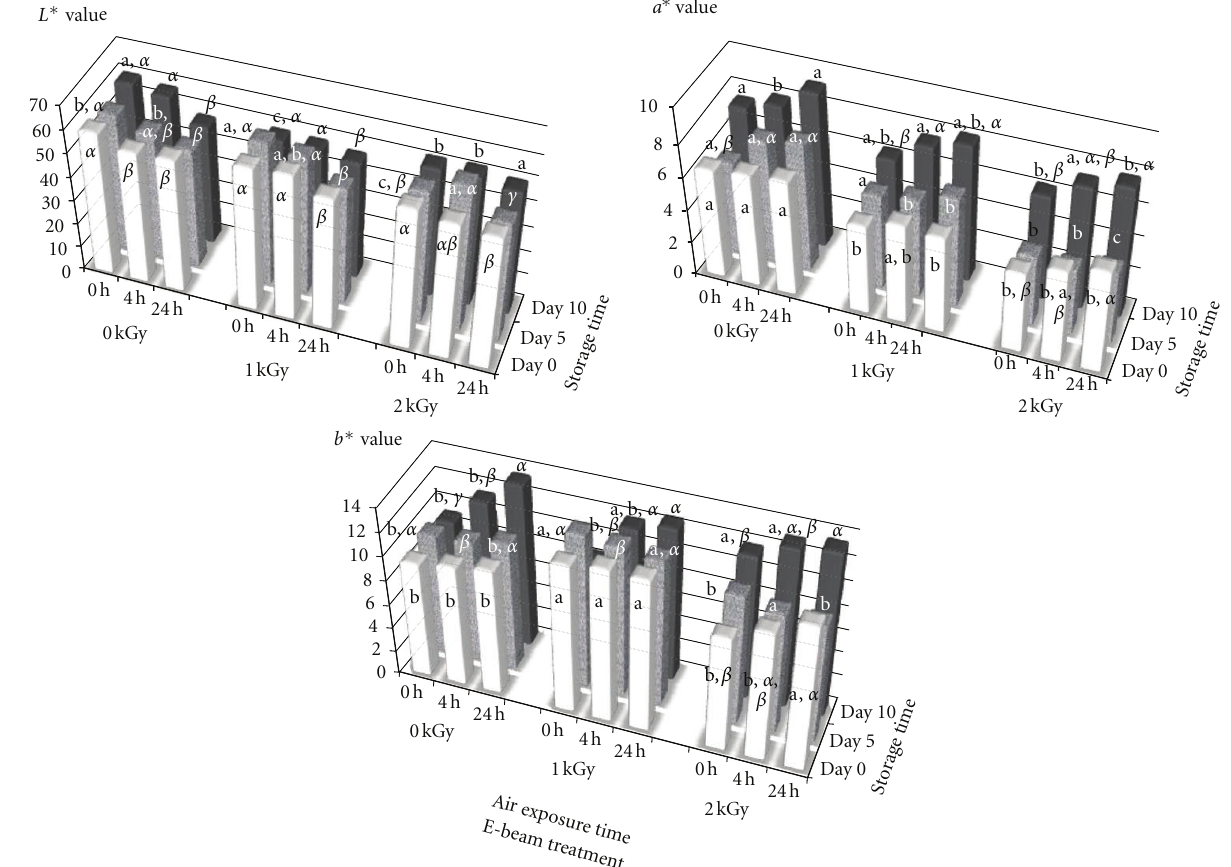
Figure 3: E ff ect of several factors (E-beam treatment, air exposure, and storage times) on the color parameters ( L ∗ , a ∗ , and b ∗ ). a, b, c in column values for storage and air exposure times with di ff erent letters are significant di ff erences ( P < 0 . 05). α , β , γ in rows values for the treatment dose and storage time with di ff erent letter are significant di ff erent ( P < 0 .